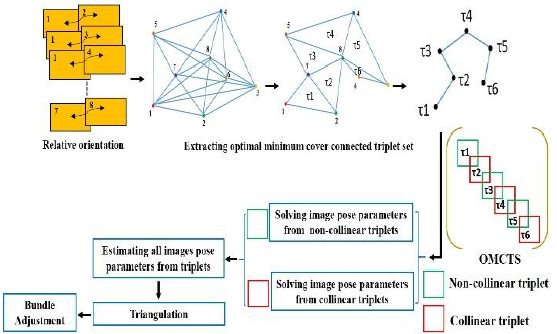
Figure 1. The workflow of our hybrid image orientation method, where in this figure τ i denotes the i -th selected